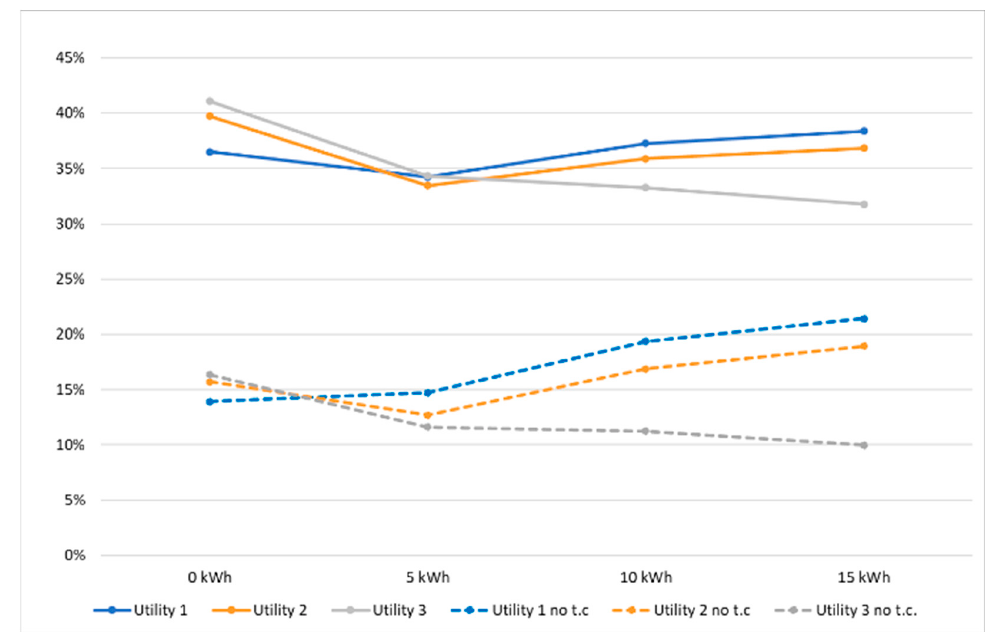
Figure 10. Annual net savings with and without tax credit for load 1, compared to ONLY-GRID.